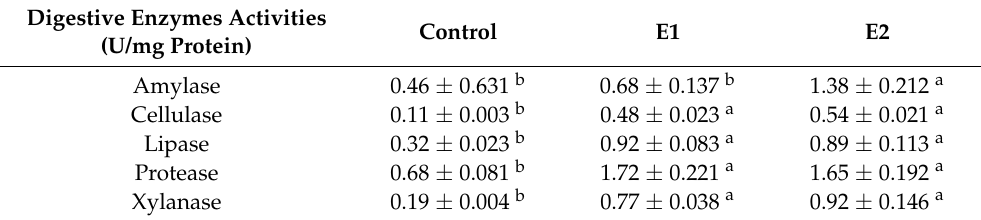
Table 2. Intestinal digestive enzyme activities and hepatic metabolic enzyme activities of zebrafish after being fed a diet containing 10 6 or 10 7 CFU/g P. ehimensis NPUST1 for 8 weeks. Digestive Enzymes Activities Control E1 E2 (U/mg Protein) Amylase 0.46 ± 0.631 b 0.68 ± 0.137 b